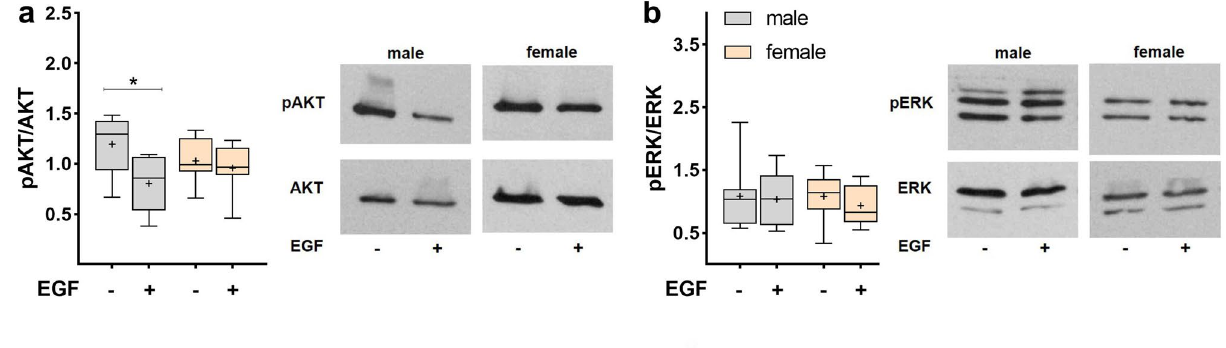
Figure 6. Effect of chronic EGF exposure on AKT-ERK1/2 phosphorylation. Data are displayed as box and whiskers with the 10–90 percentile, mean (+) and median (horizontal line). FDLE cells were cultured in SF-Med and stimulated with EGF for 24 h. ( a ) EGF reduced AKT phosphorylation in male FDLE cells (n = 8; * p < 0.05 by t -test). ( b ) In contrast, chronic EGF exposure had no significant effect on ERK1/2 phosphorylation (n = 8).